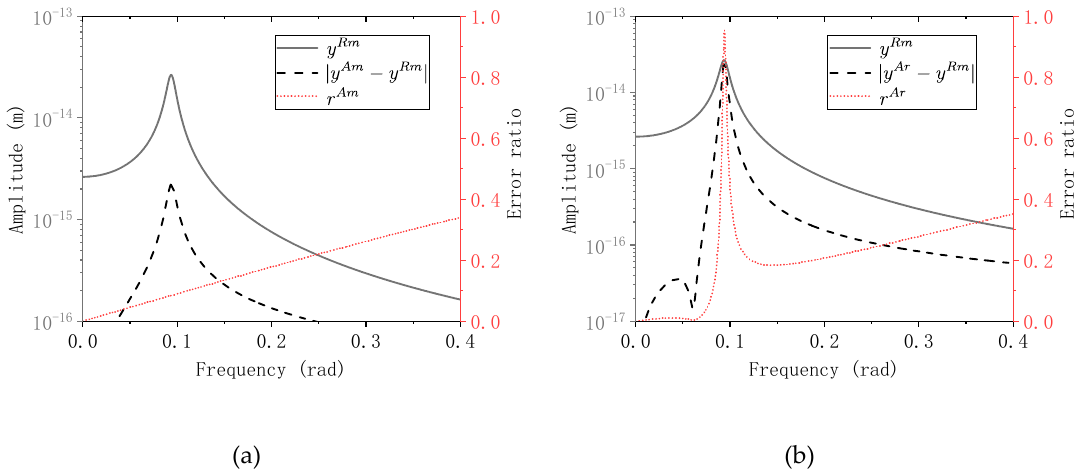
Figure 8. Reference Frequency response function, error and error ratio for different modeling method ( a ) absolute displacement method with the modal damping method (ADM-M) ( b ) absolute displacement method with the Rayleigh damping method (ADM-R).